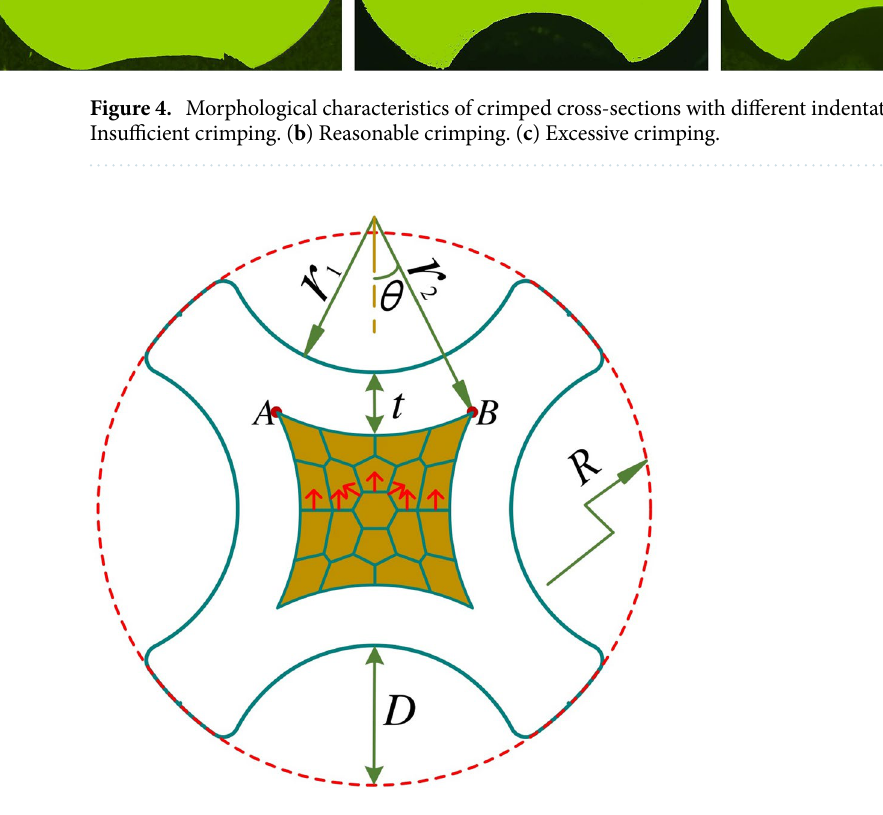
Figure 5. Schematic diagram of the 2 D geometric dimension relationship of crimped